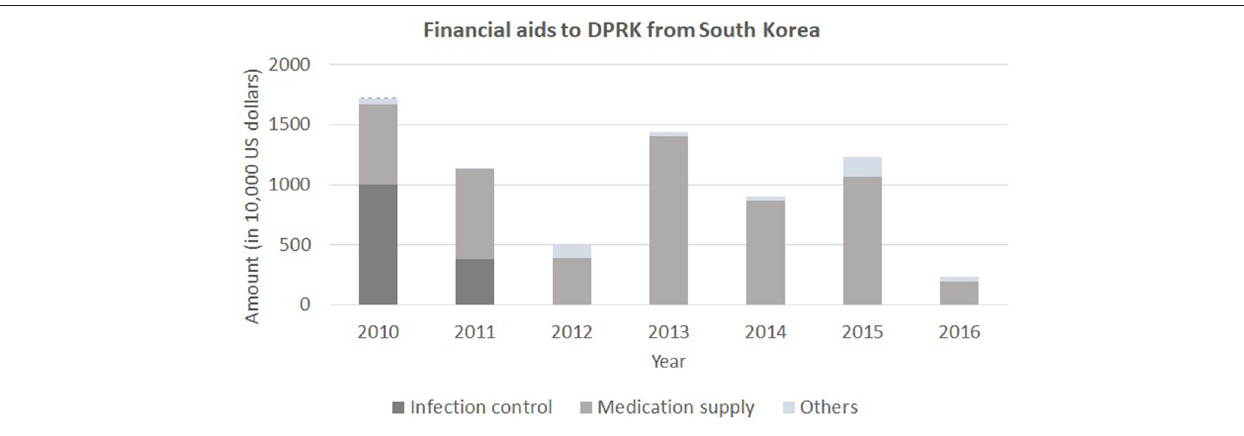
FIGURE 7 | Life expectancy at birth in the DPRK in comparison with the Republic of Korea and the nations of OECD between 1990 and 2015. Source: United Nations Population Division, World Population